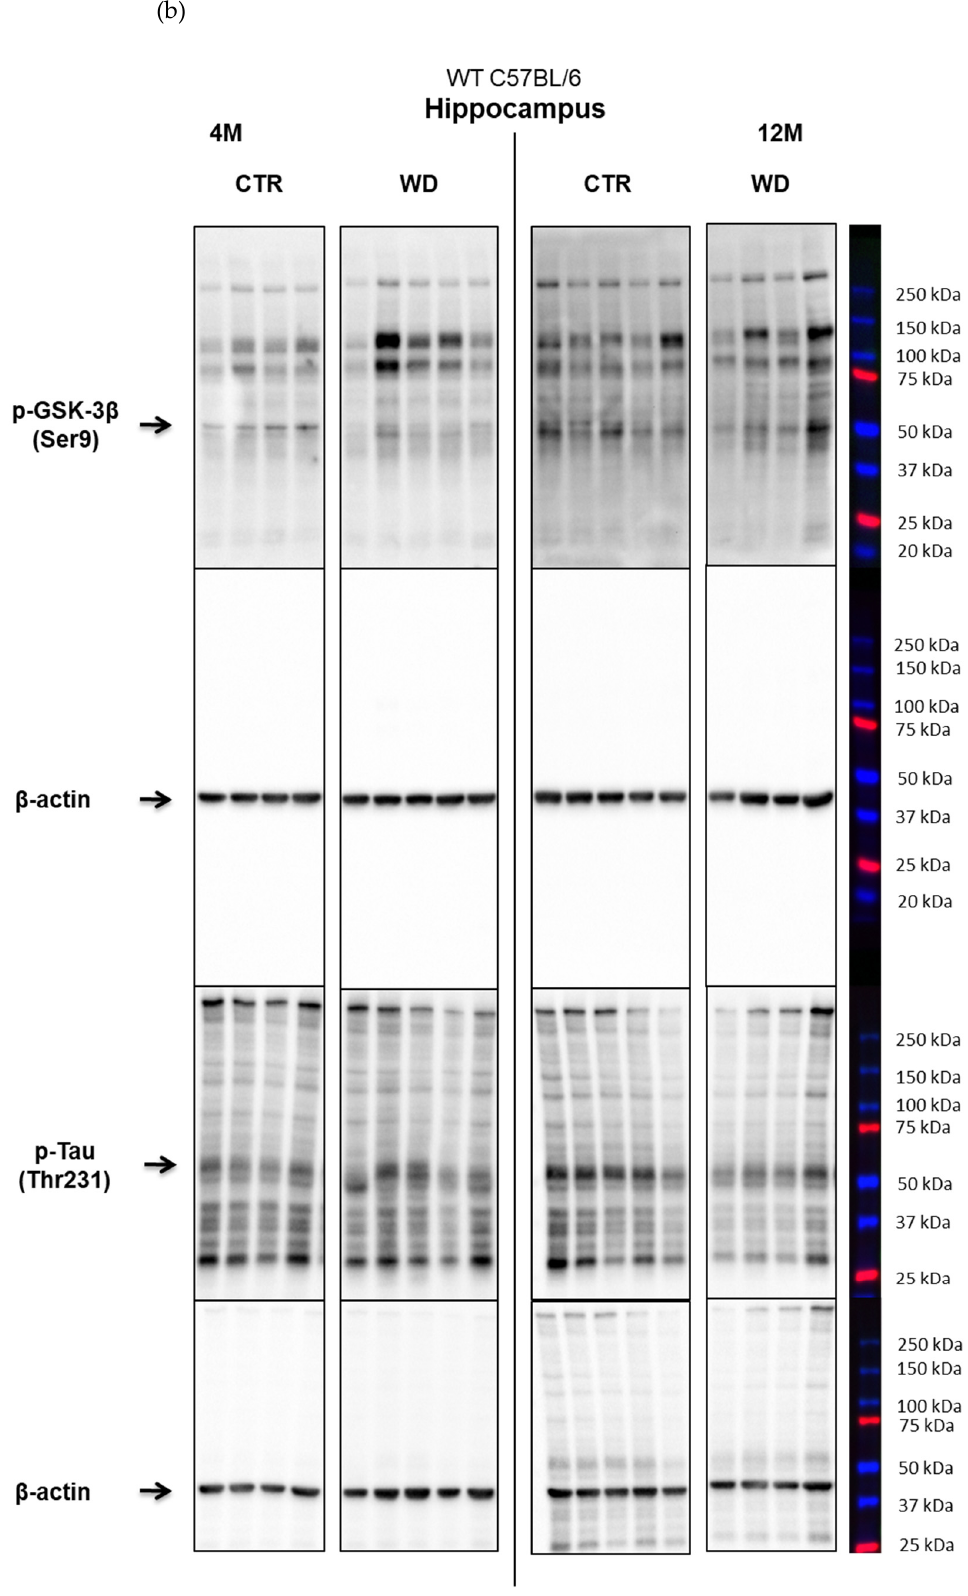
Figure A2. ( a ) The levels of p-IRS-1 (Ser616) and p-Akt (Ser473) normalized to β -actin, in the hippocampus of WT C57BL/6J mice (Section 2.2). ( b ) The levels of p-GSK-3 β (Ser9) and p-Tau (Thr231) normalized to β -actin, in the hippocampus of WT C57BL/6J mice (Section 2.2).